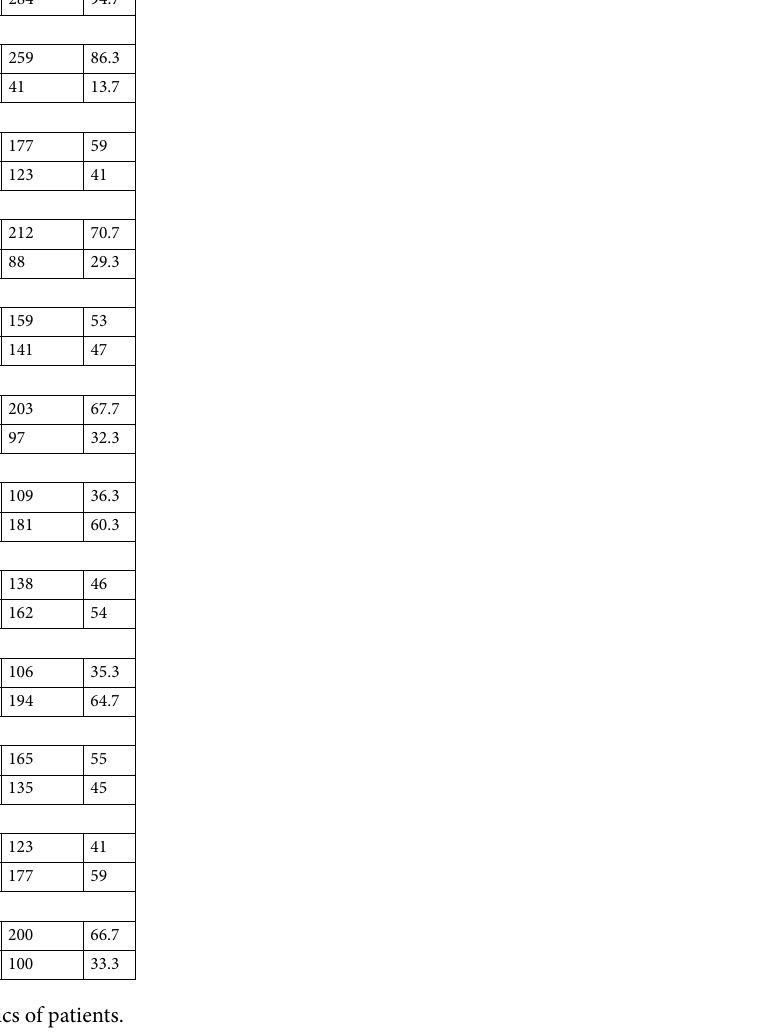
Table 1. Characteristics of